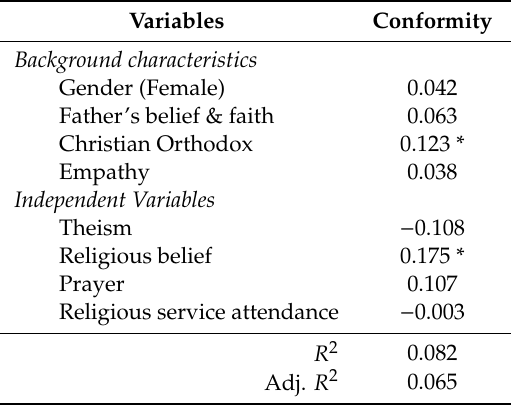
Table 5. Regression analysis for conformity with weights ( β ) for each variable and total explained variance ( R 2 and adjusted R 2 ).